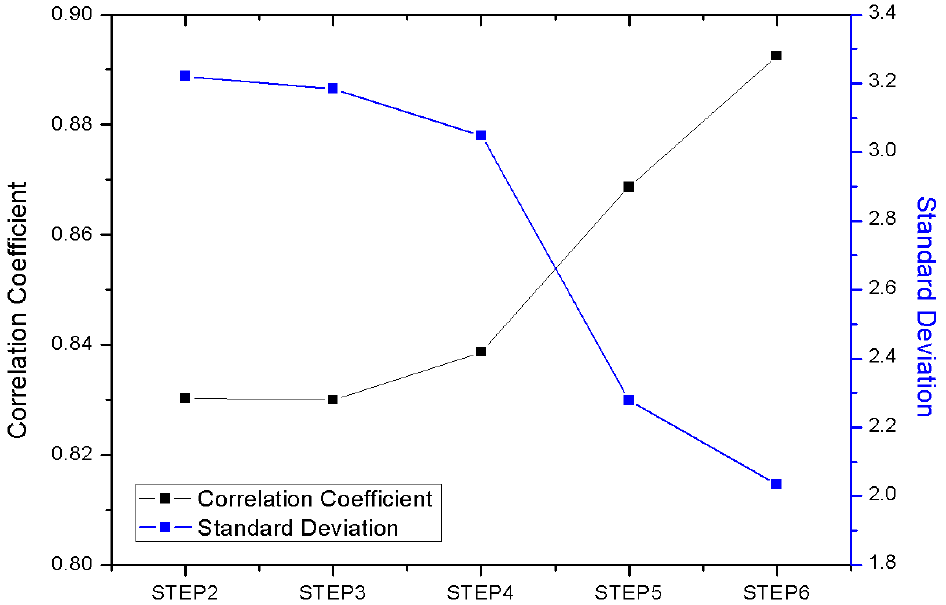
Figure 5. Correlation coefficient (black) and standard deviation (blue) of match-up dataset. STEP2 represents the original match-up dataset of Mosaic Reflectivity and KuPR. STEP3–STEP6 represent the match-up dataset output from STEP3 to STEP6.